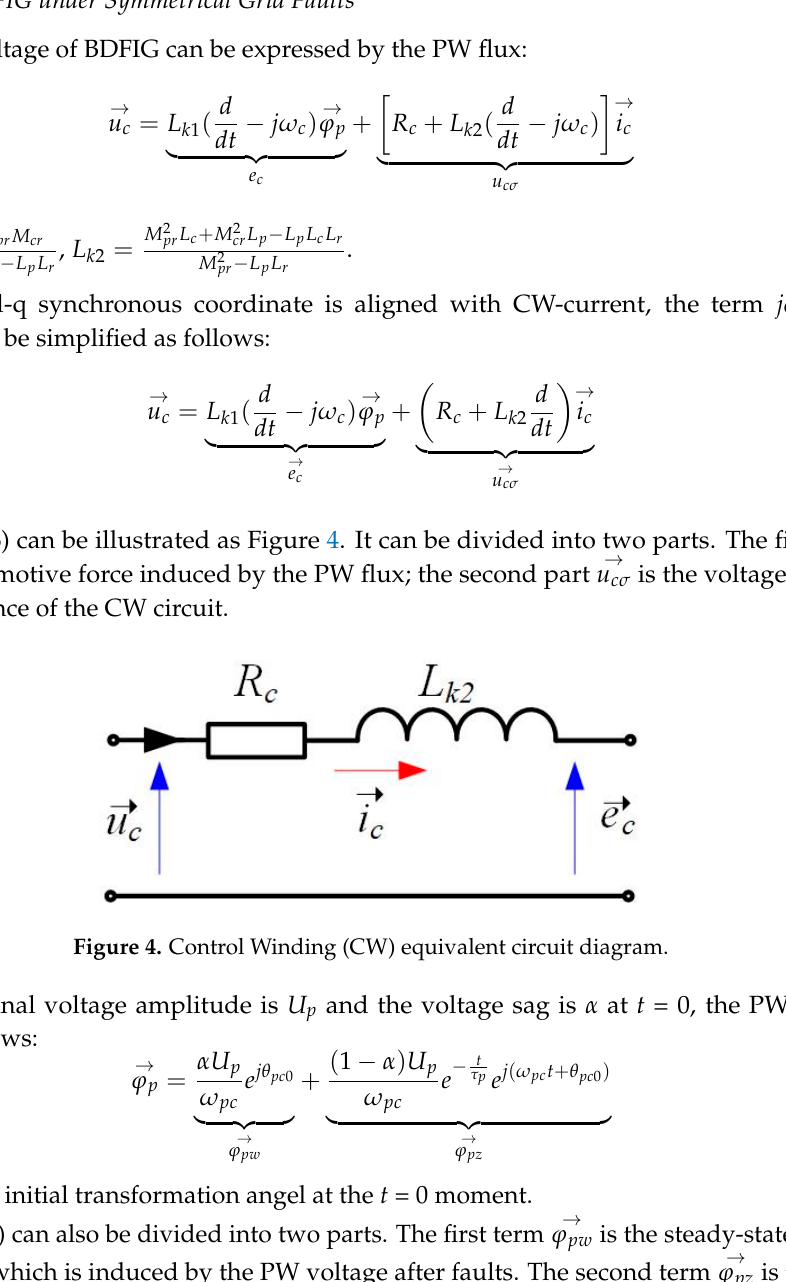
( b ) Figure 3. The vector diagrams before and after operation point changes . 3. Transient Characteristics of BDFIG Based on VSC in Symmetrical Grid Faults Dynamic behavior described by Equation (1) is relatively slow (the regulation usually prolongs tens of fundamental periods or even longer), and therefore, the applicability of the VSC strategy in the case of grid faults needs to be considered. Transient characteristics during a symmetrical grid